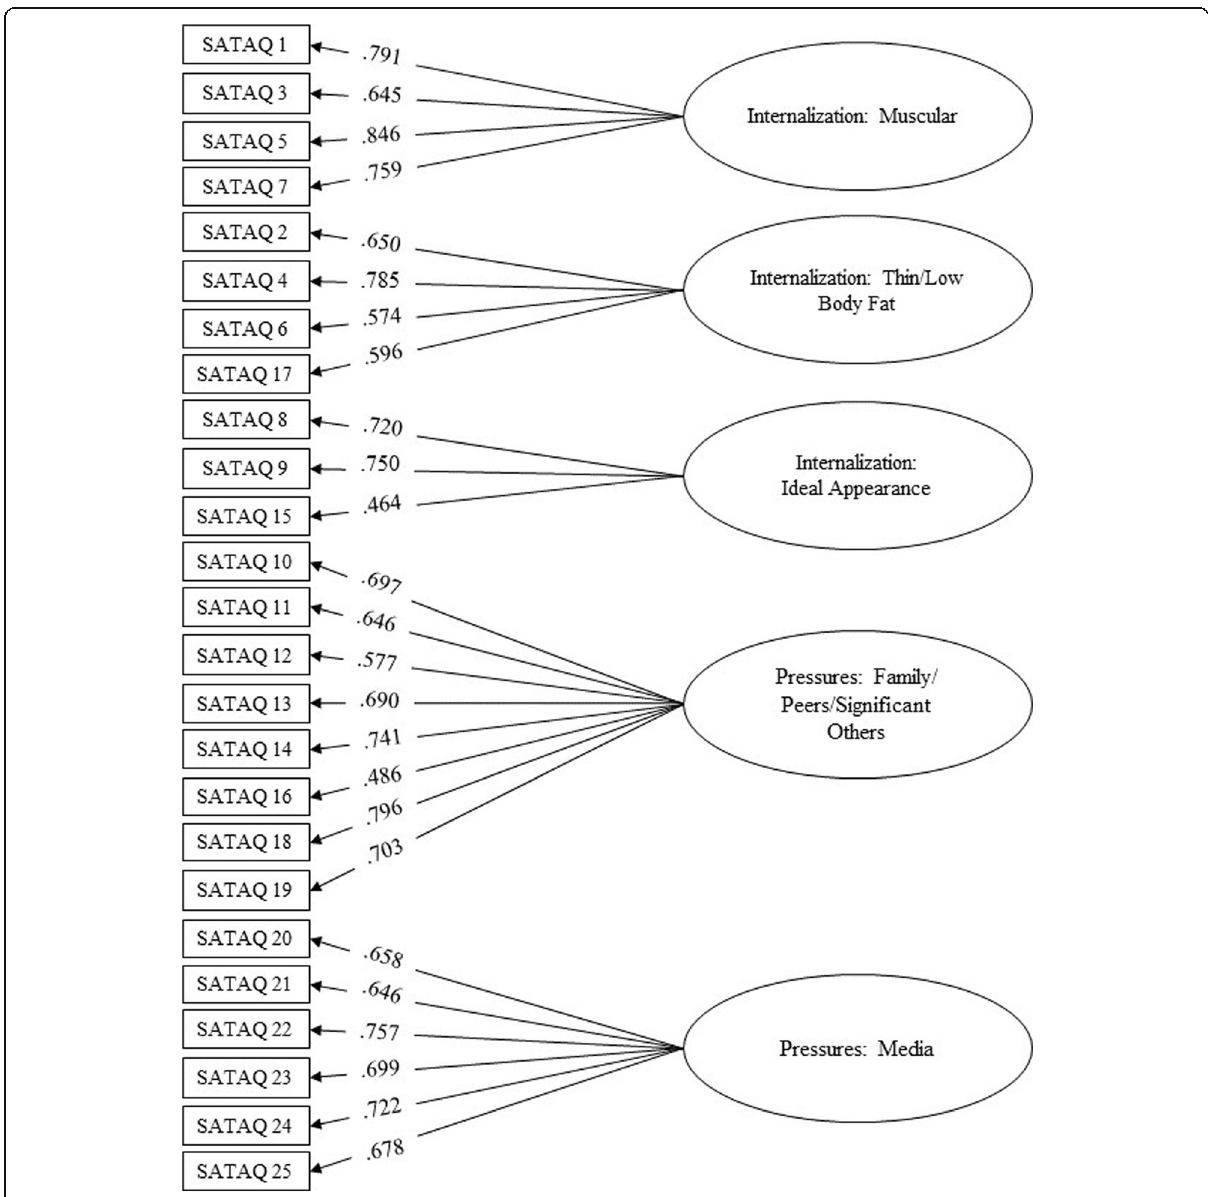
Fig. 2 Factor structure of the SATAQ-4R for Brazilian